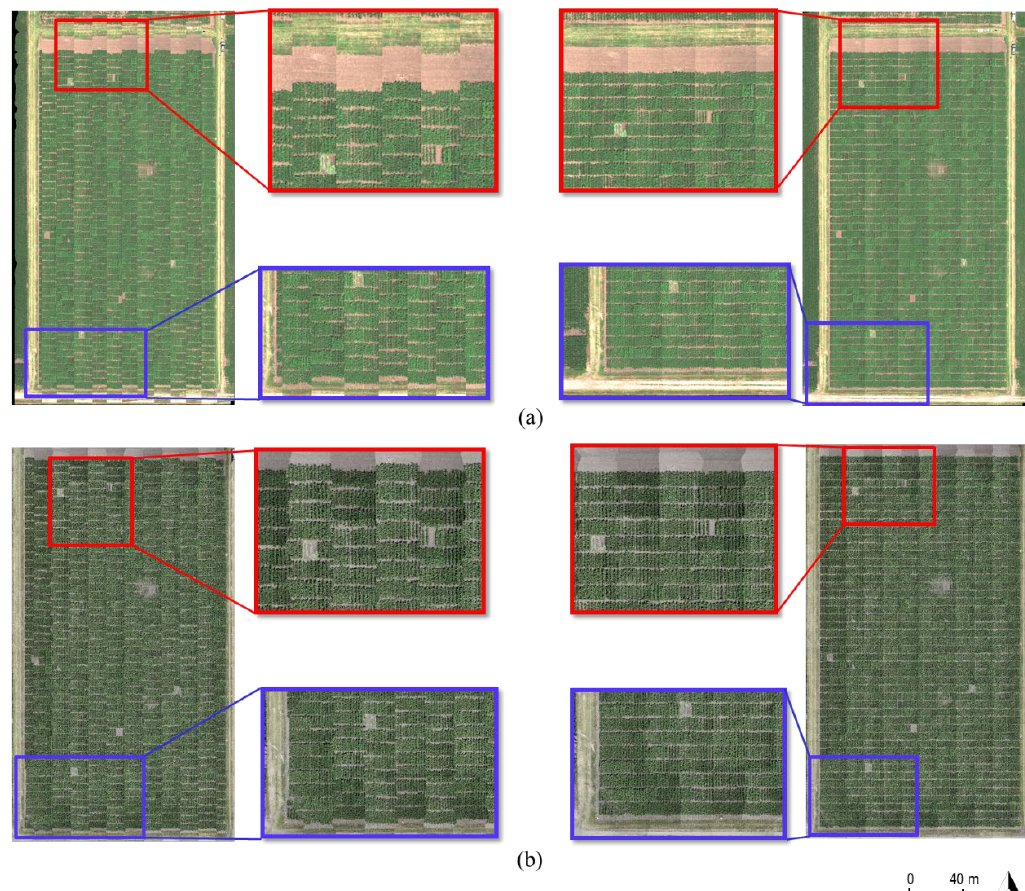
Figure 7. Orthophotos generated from nominal (left) and estimated boresight angles (right) for the Agriculture dataset: (a) HS orthophotos and (b) RGB orthophotos.